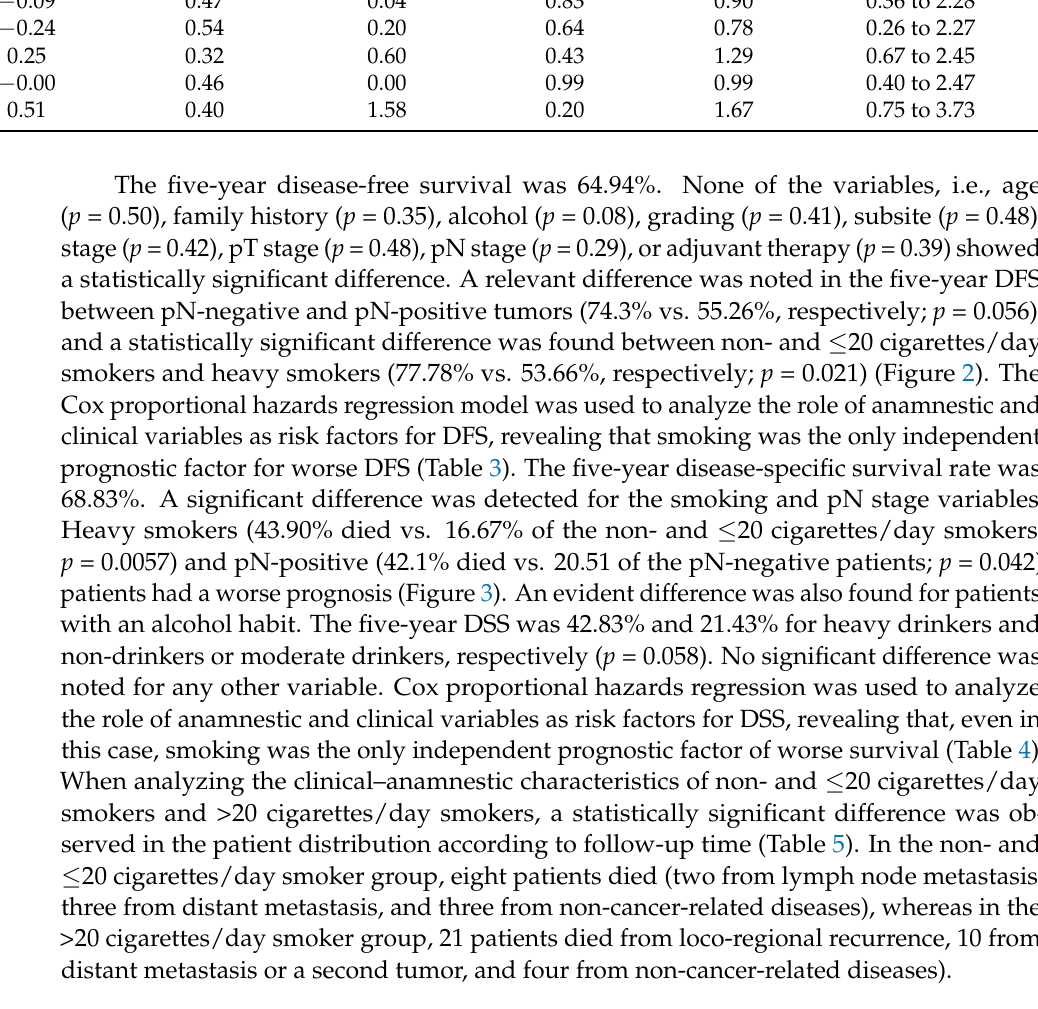
Table 3. Cox proportional-hazards regression analysis of the clinical-anamnestic data as risk factors on 5-years Disease Free